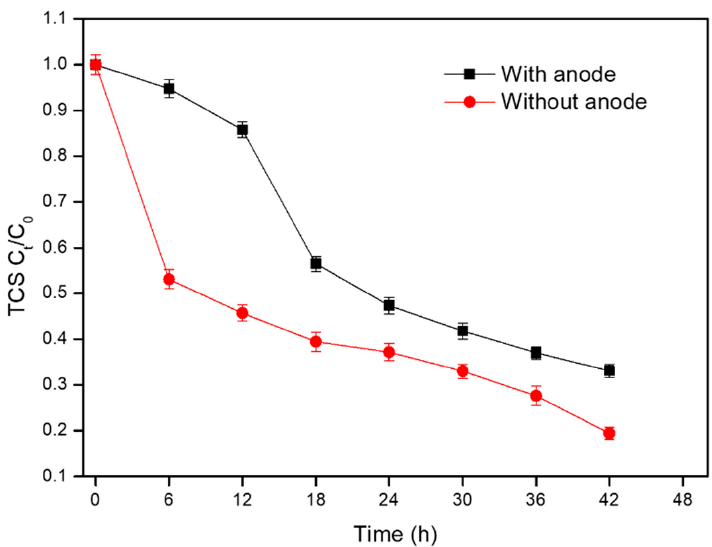
Figure 3. The TCS adsorption in control reactors with or without anode electrodes under abiotic conditions.